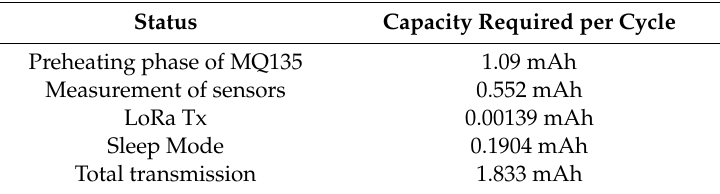
Table 6. Summary of consumption calculation per